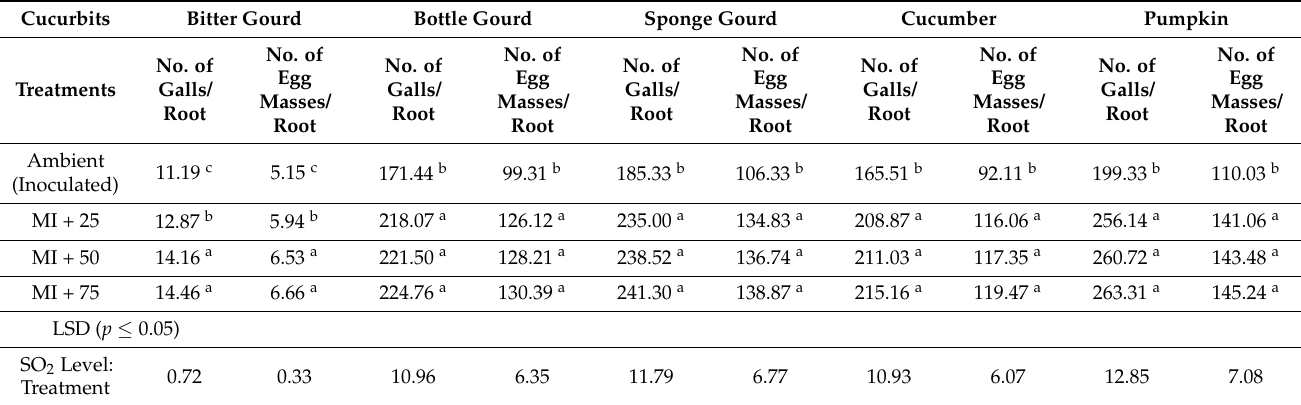
Table 1. Effect of intermittent exposures of SO 2 (ambient, 25, 50, and 75 ppb) on the number of